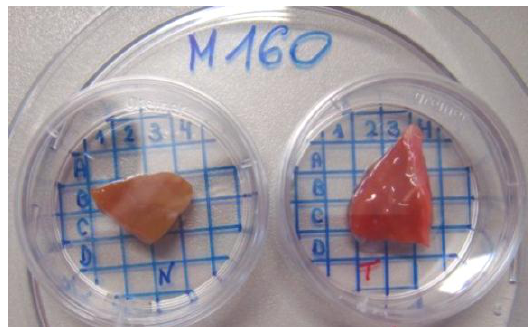
Figure 1. Renal biopsy of patient 160: healthy ( left ) and tumor ( right ) tissue.